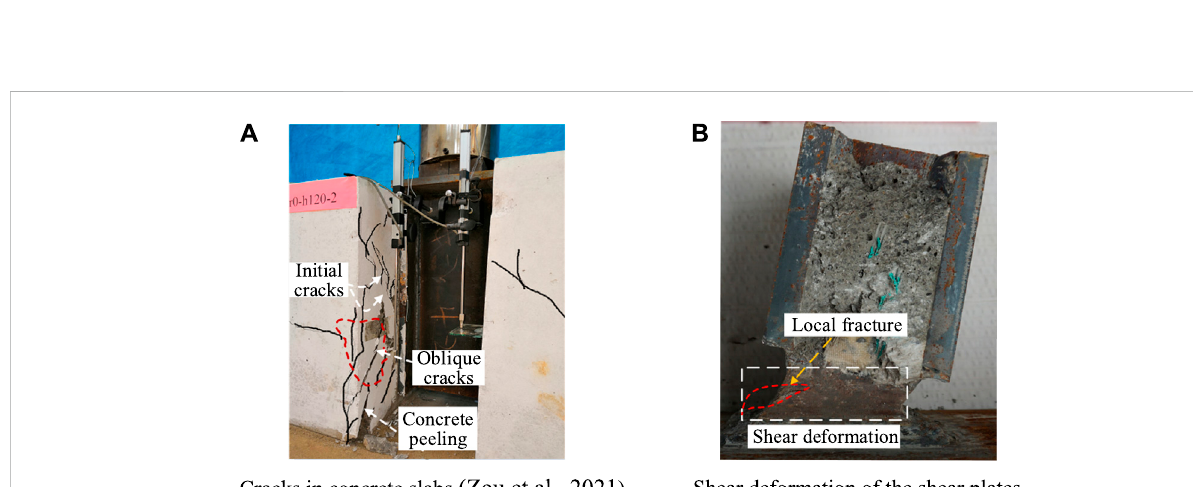
steel and concrete structures, 2005), the loading time of each specimen was not less than 15 min. No. 1 specimens of each group were monotonously loaded, and No. 2 and No.